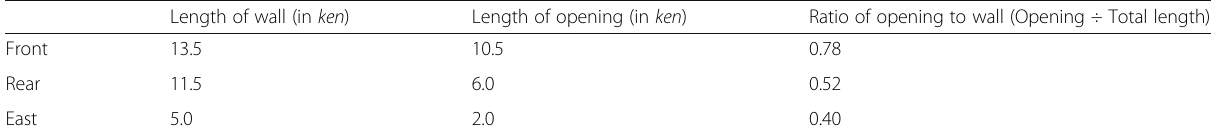
Table 2 Ratio of opening to walls of the sericulture space in the omoya after modification. West wall openings do not appear, as they fell in disuse in 1925. (Source: Sweet Yee Cheng) Length of wall (in ken ) Length of opening (in ken ) Ratio of opening to wall (Opening ÷ Total